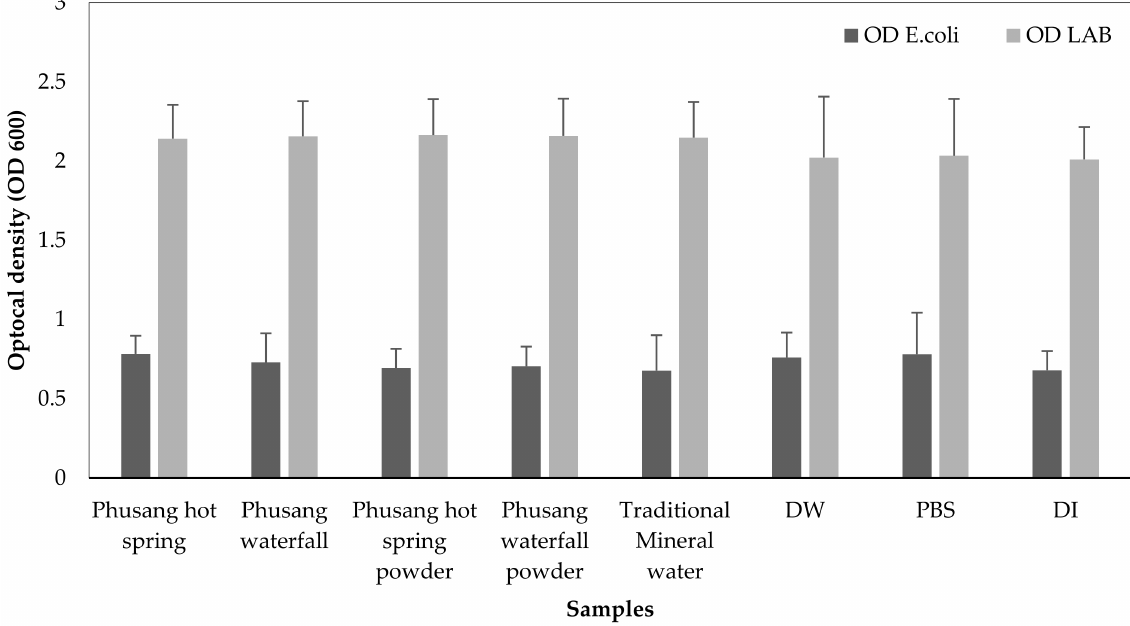
Figure 12. Differences in OD values of E. coli and LAB treated with different water samples. E. coli CFUs/mL were not significantly